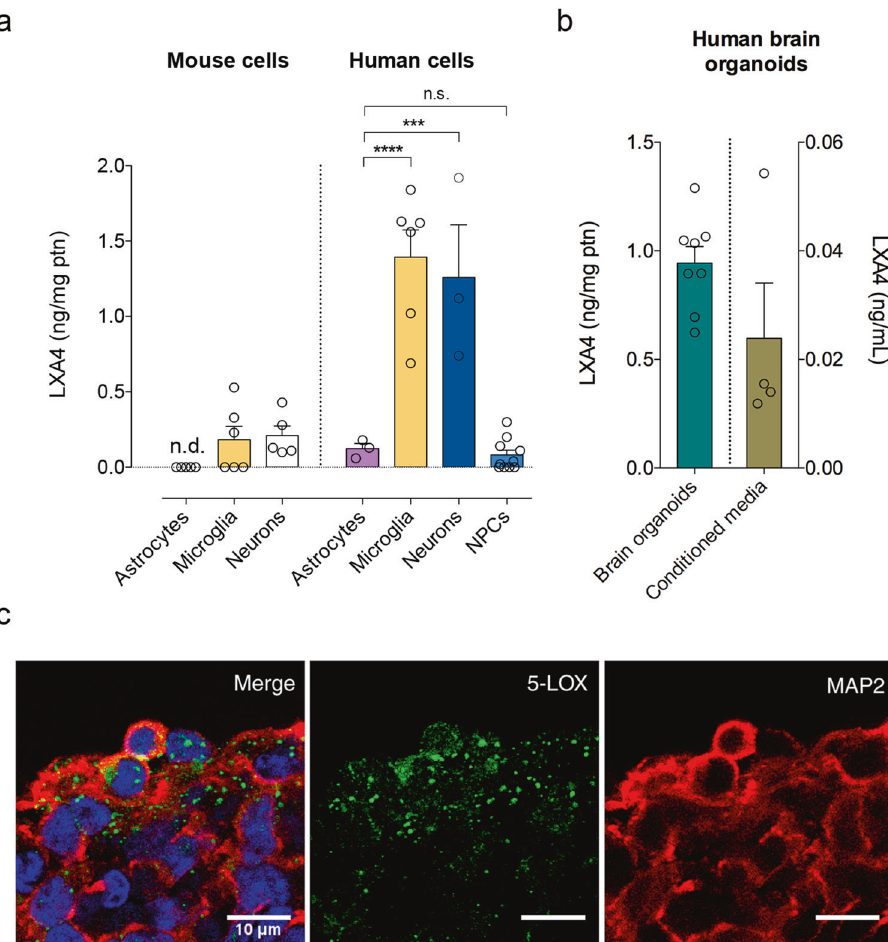
Fig. 1 LXA4 is produced by neurons and microglia. a Levels of lipoxin A4 (LXA4) in primary cultures enriched in astrocytes, microglia or neurons derived from mice (left) ( N = 5 for astrocytes and neurons, 6 for microglia) or in human iPSC-derived astrocytes, microglia, neurons, or neural progenitor cells (NPCs) ( N = 3 for astrocytes and neurons, 6 for microglia, and 10 for NPCs). Unpaired two-tailed one-way ANOVA with Š idák post hoc test (*** p < 0.001; **** p < 0.0001; n.s. nonsigni fi cant). n.d. not detected. b Levels of LXA4 in the lysates (green bar) or conditioned media (brown bar) of human brain organoids ( N = 8 for lysates, 4 for conditioned media). c Representative images of immuno fl uorescence experiments (5-lipoxygenase, 5-LOX immunoreactivity: green; microtubule-associated protein 2, MAP2 immunoreactiv- ity: red; DAPI: blue; N = 3) in human iPSC-derived brain organoids. Scale bar: 10 μ